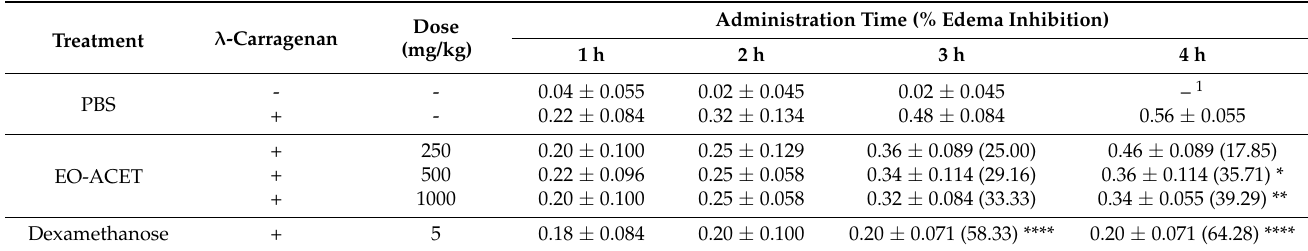
Table 2. Thickness in millimeters and percentage of λ -carrageenan 1% paw edema inhibition in BALB/c mice treated with ethyl acetate fraction of Euterpe oleraceae .